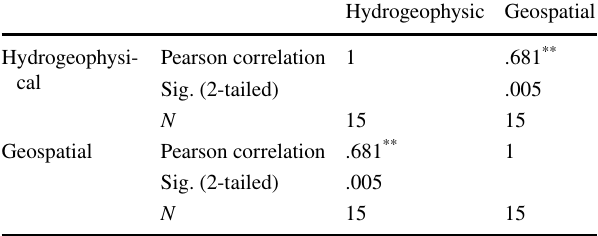
The double asterisk (**) shows that the correlation is significant at 0.01 level